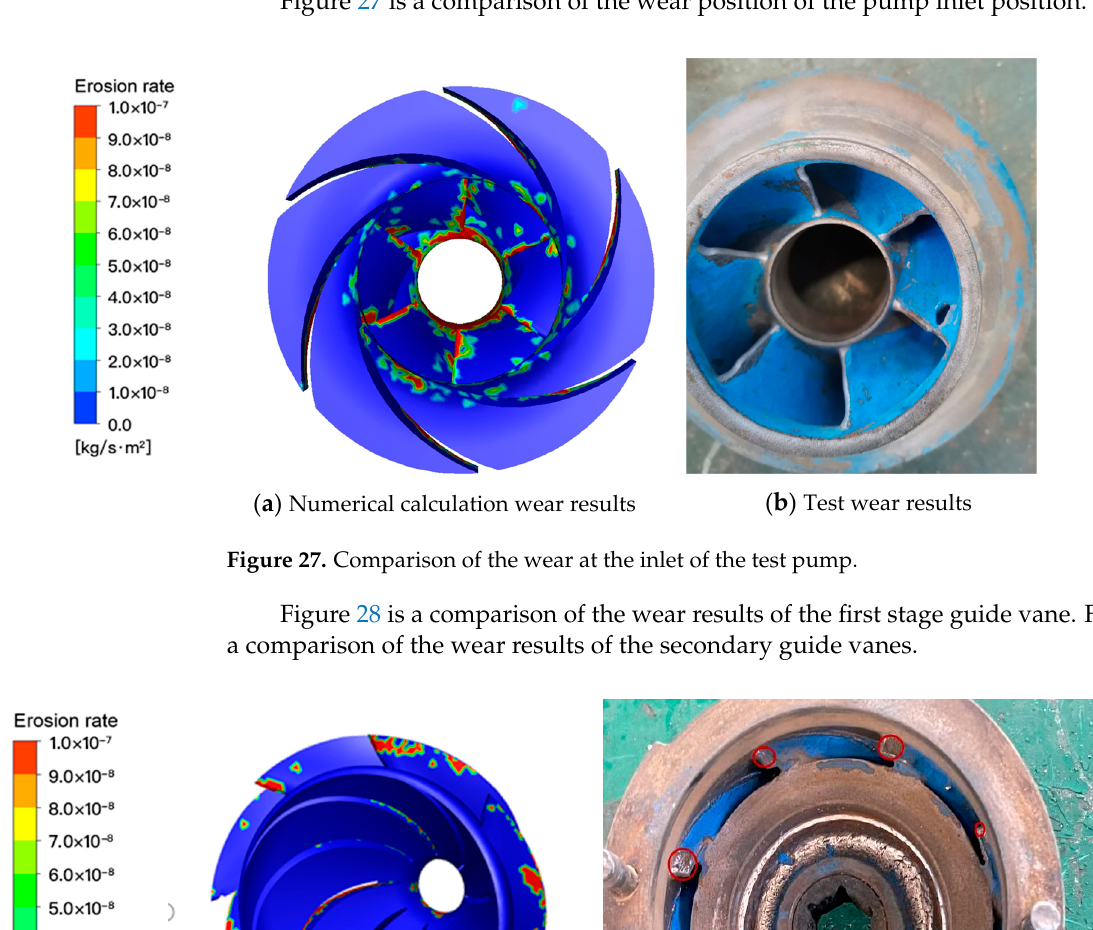
Test pump installation ( b ) Test system operation Figure 26. Test site.